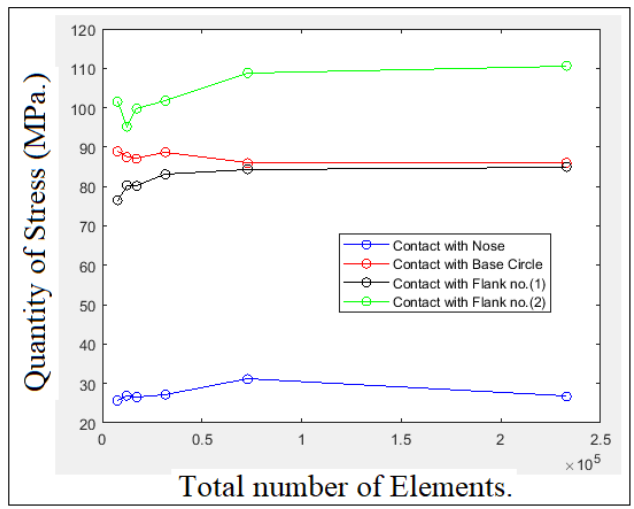
Figure 9. Convergence test of the contact stress quantity at different contact locations for profile no.(1).